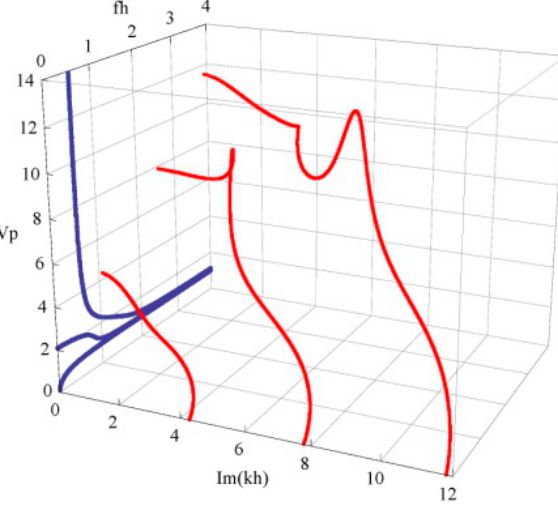
Figure 6. The phase velocity dispersion and attenuation curves; propagating wave in blue, evanescent wave in red.